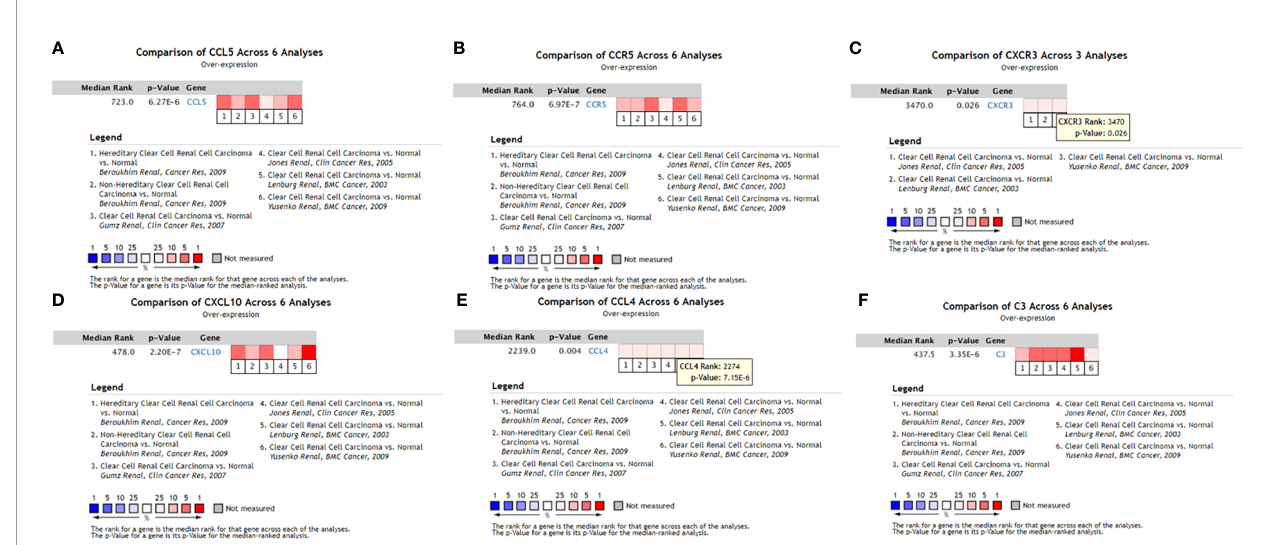
FIGURE 7 | Expression levels of six hub genes of the PPI network veri fi ed in Oncomine. (A) CCL5 meta-analysis results in the Oncomine database; (B) CCR5 meta- analysis results in the Oncomine database; (C) CXCR3 meta-analysis results in the Oncomine database; (D) CXCL10 meta-analysis results in the Oncomine database; (E) CCL4 meta-analysis results in the Oncomine database; (F) C3 meta-analysis results in the Oncomine database. ccRCC, clear cell renal cell carcinoma.